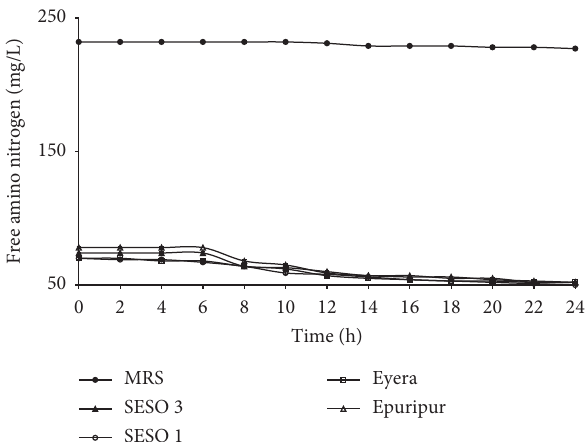
Figure 5: Reduction in total sugars during growth of L. plantarum MNC 21 in MRS broth and malt extracts from different sorghum varieties. Error bars show standard deviations of three independent Table 2: Overall utilization of free amino nitrogen and total sugars by L. plantarum MNC 21 after 24h (30 ° C) in MRS broth and malt extracts from different sorghum varieties.